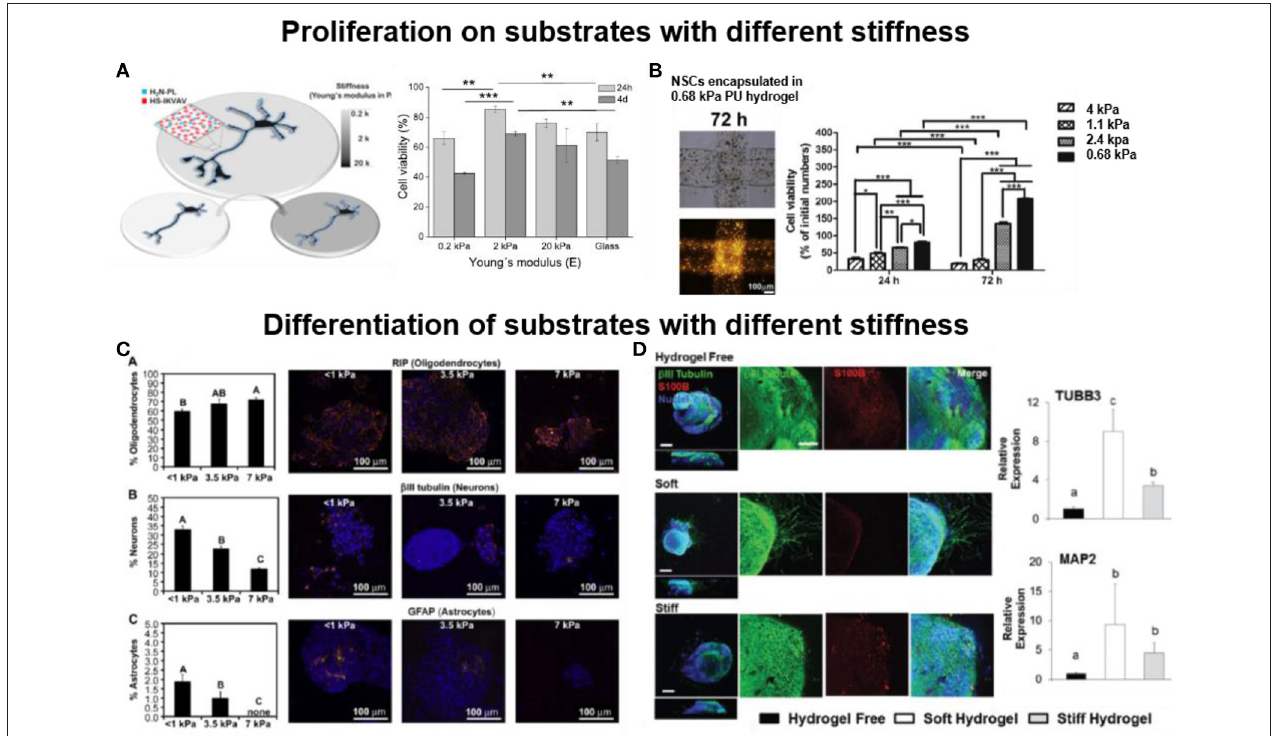
FIGURE 3 | Influence of the stiffness of the biomaterial in cell proliferation and differentiation (A) Soft (2 kPa) 2D polyacrylamide hydrogels functionalized with PL and IKVAV support proliferation of NSCs during 4 days of culture (Farrukh et al., 2017a) Copyright 2017, The Authors; (B) Soft (0.68 kPa) 3D polyurethane hydrogel encapsulating NSCs enhance proliferation of encapsulated cells ( Hsieh et al., 2015) Copyright 2015, Elsevier; (C) Soft ( < 1 kPa) 2D methacrylamide chitosan hydrogel on glass, preferentially support neuronal differentiation of NSPCs during 8 days of culture ( Leipzig and Shoichet, 2009) Copyright 2009, Elsevier; (D) Soft (0.5 kPa) 3D hyaluronic acid hydrogels trigger neurite extension from hiPSC-NPC spheroids, while stiff (1.4 kPa) hydrogel failed to support neurite extension, after 28 days of culture ( Wu et al., 2017) Copyright 2017, Royal Society of